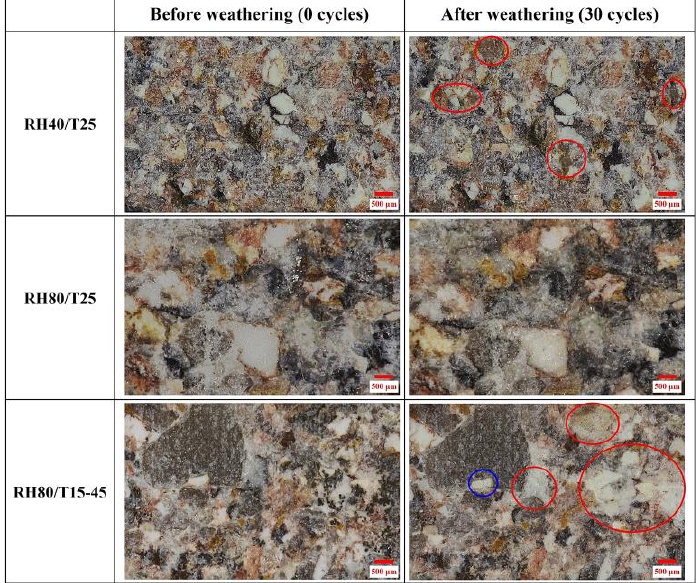
Figure 7. Photographs of surfaces of sandstone specimens before and after weathering tests.